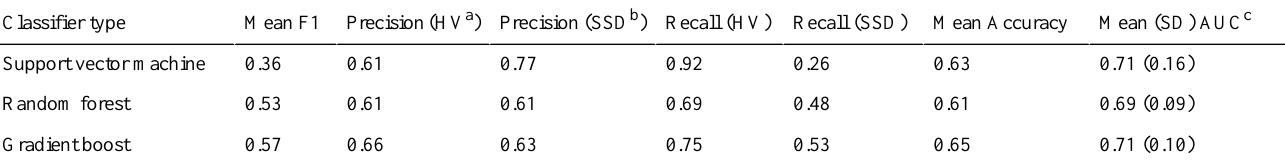
Table 5. Relapse classifier results.